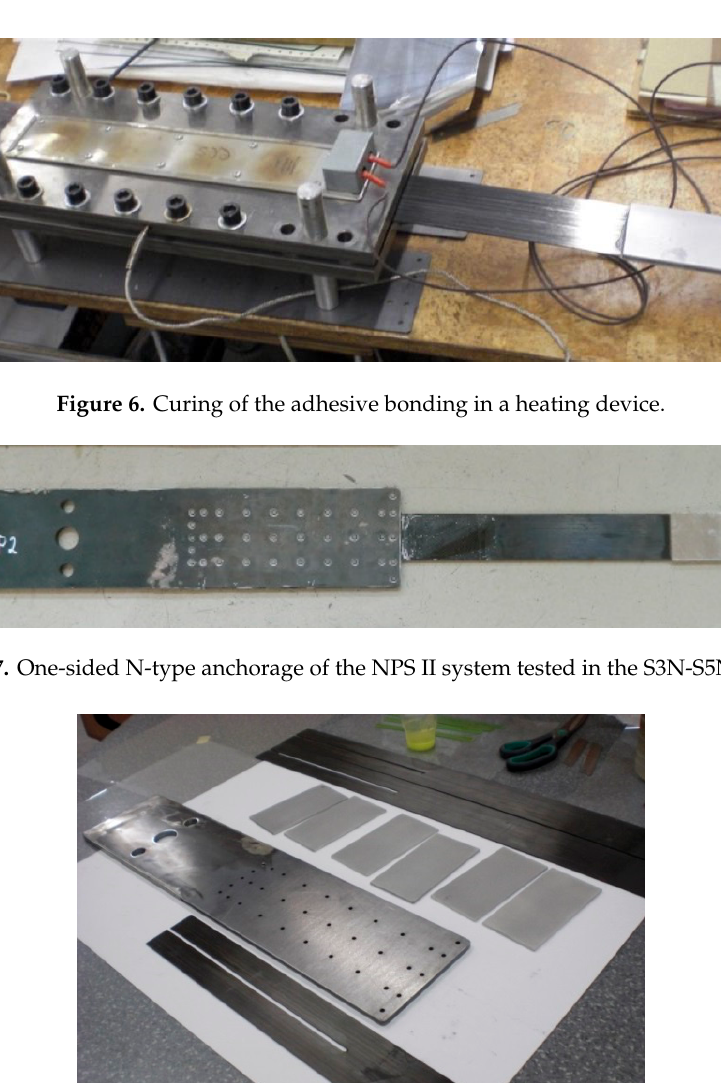
Figure 8. Elements of the S4N series’ specimens prepared for bonding (longitudinal cut in the strip).